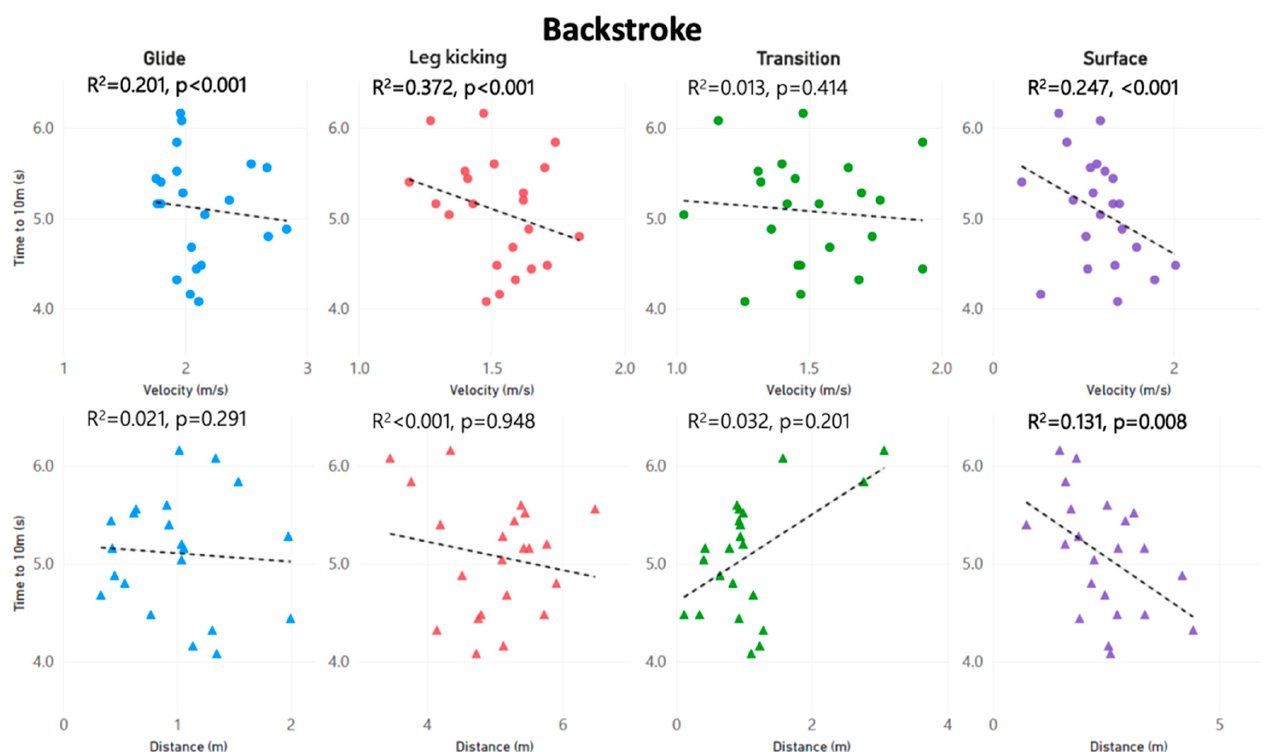
Figure 1. Relationships between distance and velocities of competitive swimmers on the freestyle, butterfly and backstroke push start sub-phases and the times to 10 m. Table 2. The results from the linear multiple regression model with the coefficients and their 95% confidence intervals for each phase of the push